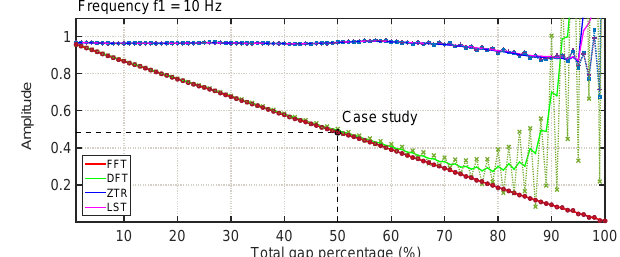
Figure 5. SLG test applied to the synthetic data: amplitude of the 10Hz sinusoidal mode (f 1 ) as a function of TGP for: FFT (red line marked with circles), DFT (green with x), ZTR (blue and square) and LST (magenta and + ). The case study for a TGP of 50% (see Fig. 3) is noted as a vertical black line, and the horizontal black line gives the FFT amplitude for this case.